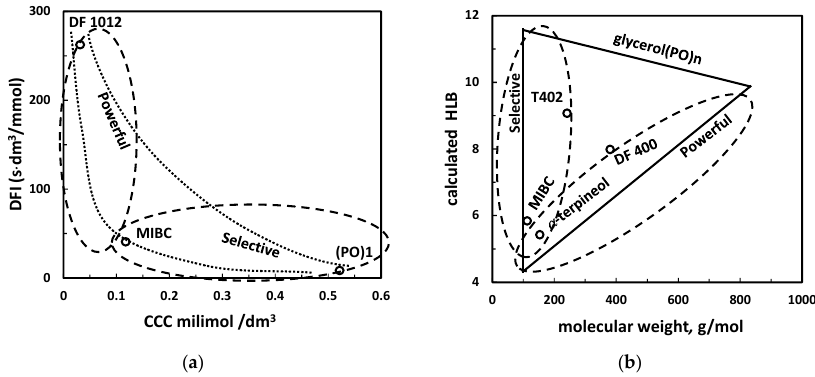
Figure 17. Classification of a frother into selective and powerful category resulting from a relation between either ( a ) DFI/CCC or ( b ) HLB/MW and a trend in selectivity of fine and coarse particles flotation, respectively ([45] with modification).